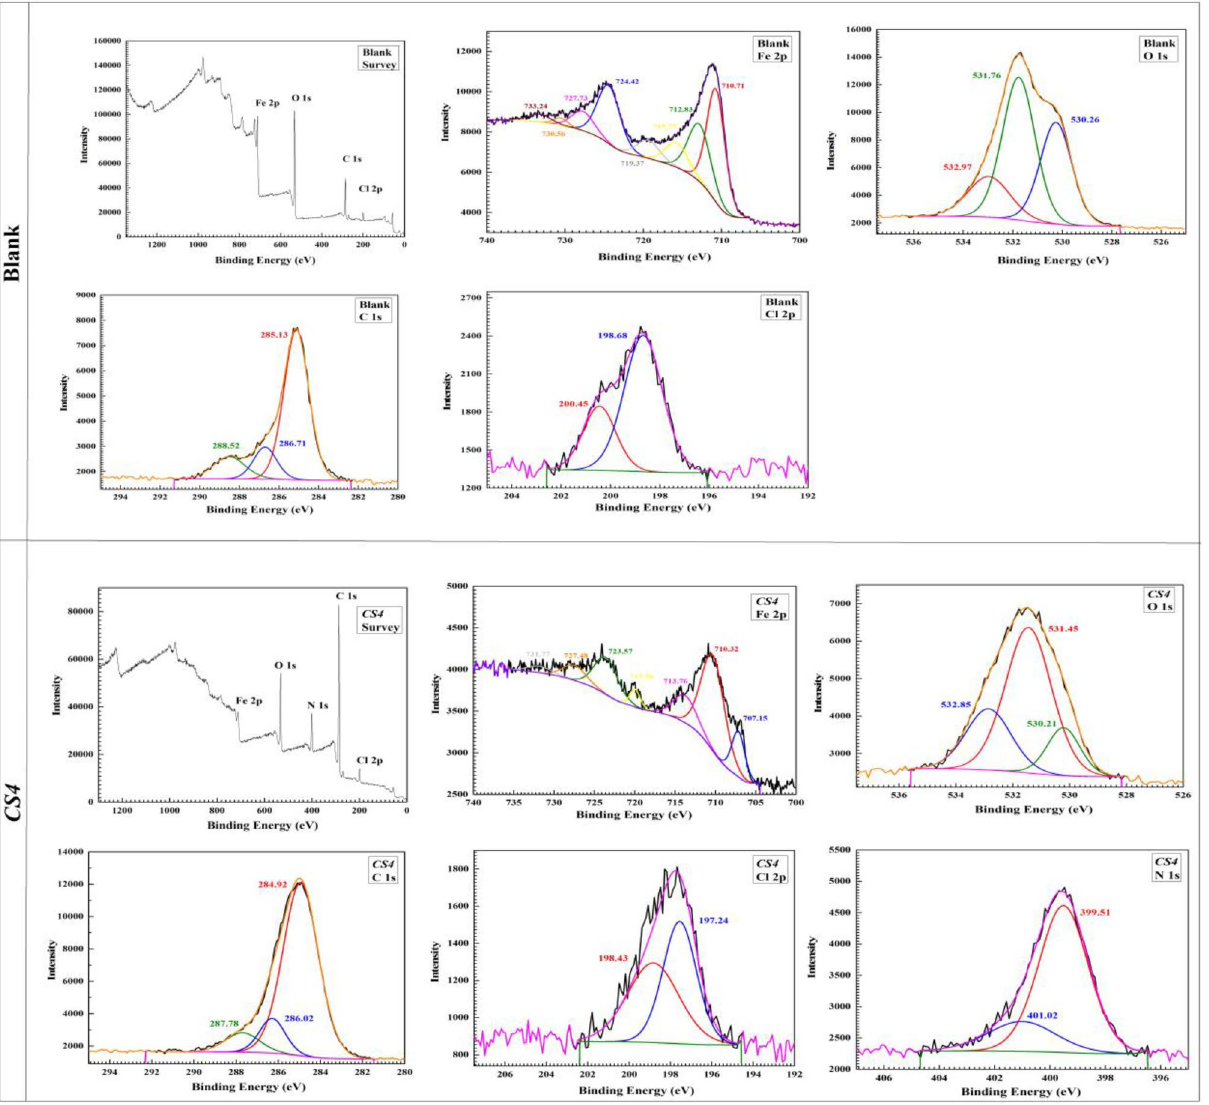
Figure 14. XPS analysis for CS -metal surface in absence and presence of CS4